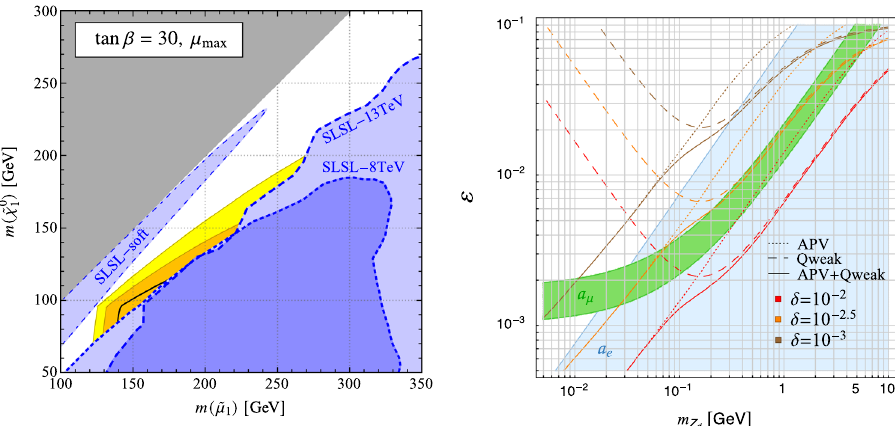
Fig. 5 Left: Plot from Ref. [249] showing the neutralino-smuon mass range still allowed after considering LHC constraints (shaded blue areas) for a MSSM ( g − 2 ) μ solution at 1 σ (2 σ ) in orange (yellow), with a bino-like LSP, degenerate smuons and tan β = 30. Right: Plot from Ref. [264] showing in green (light blue) the preferred region by